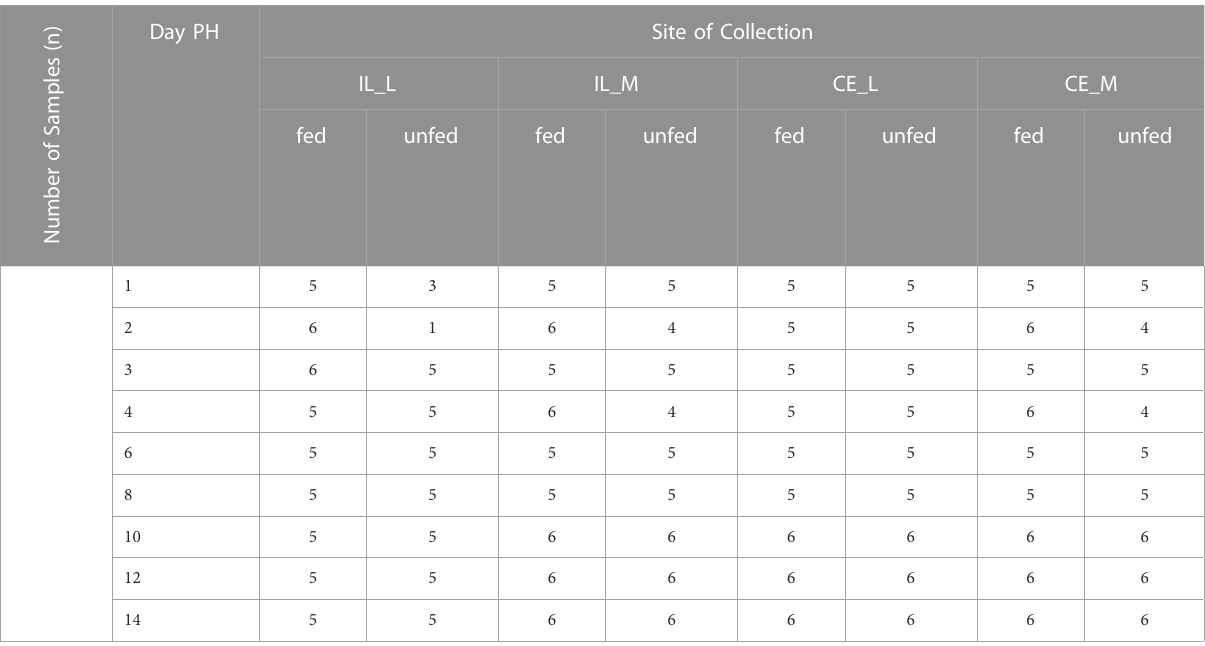
TABLE 1 Experimental design indicating all factors tested in this